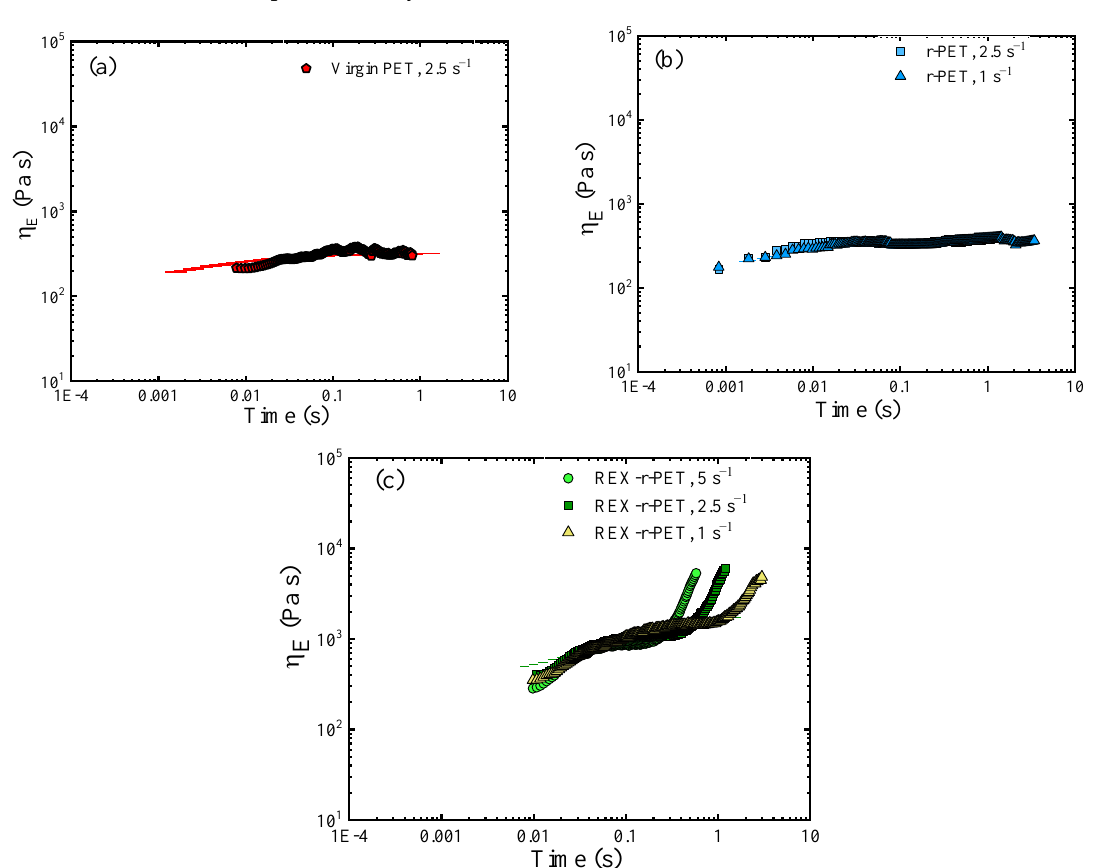
Figure 10. Elongational viscosities for the three PET samples: ( a ) virgin PET, ( b ) r-PET, and ( c ) REX-r-PET.